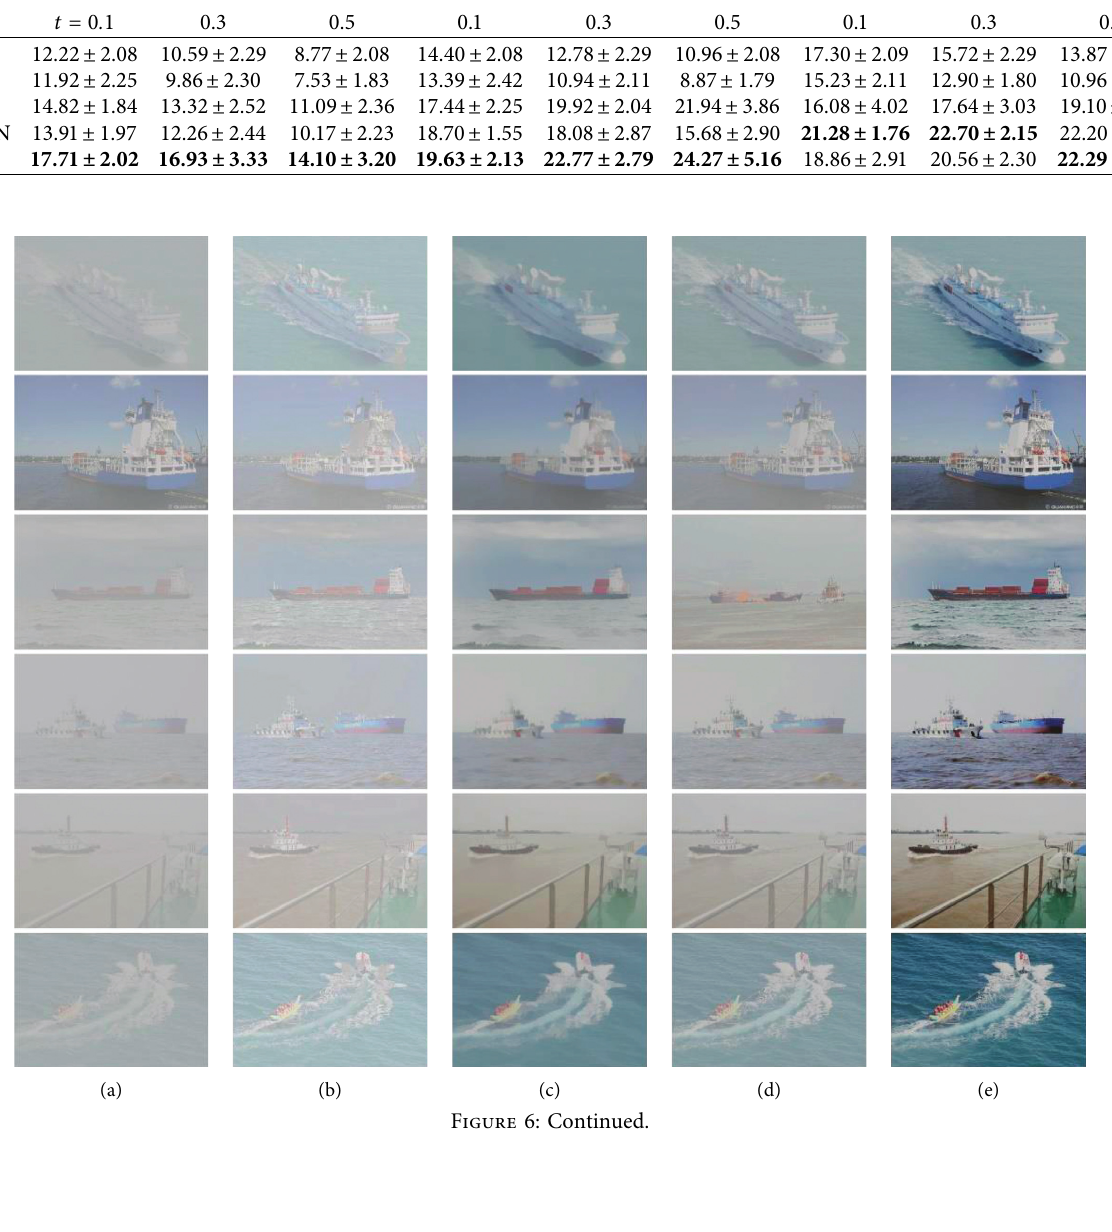
Table 2: SSIM comparisons (mean ± std) of various dehazed methods on all test images shown in Figure 5. A � 0 . PSNR